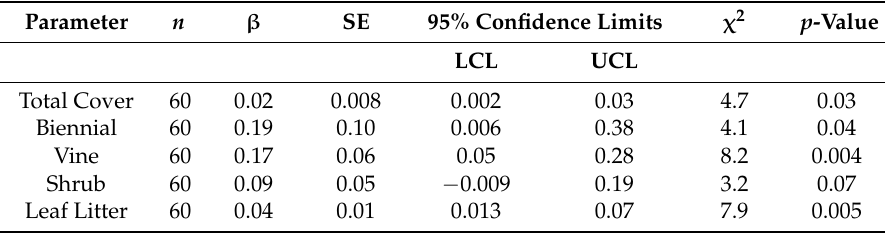
Table 3. Coefficient ( β ), standard error (SE), 95% confidence limits, and chi-square test of significant habitat variables on presence of larval Amblyomma americanum (L.) collected in 2015 and 2016.